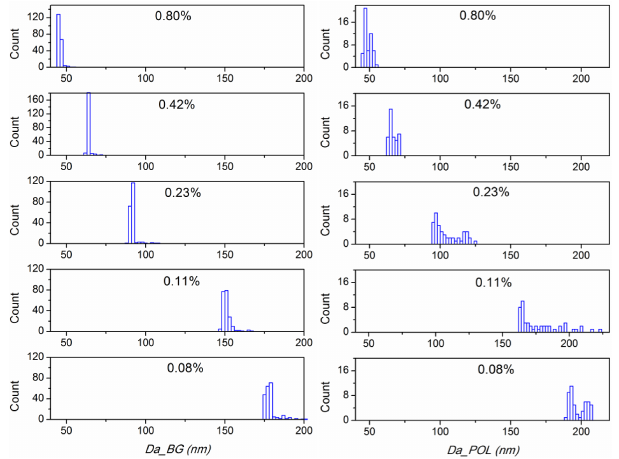
Figure 4. Probability distribution functions of κ a under background (_BG, left panels) and polluted (_POL, right panels) conditions for different particle size ranges during the size-resolved CCN mea- surement